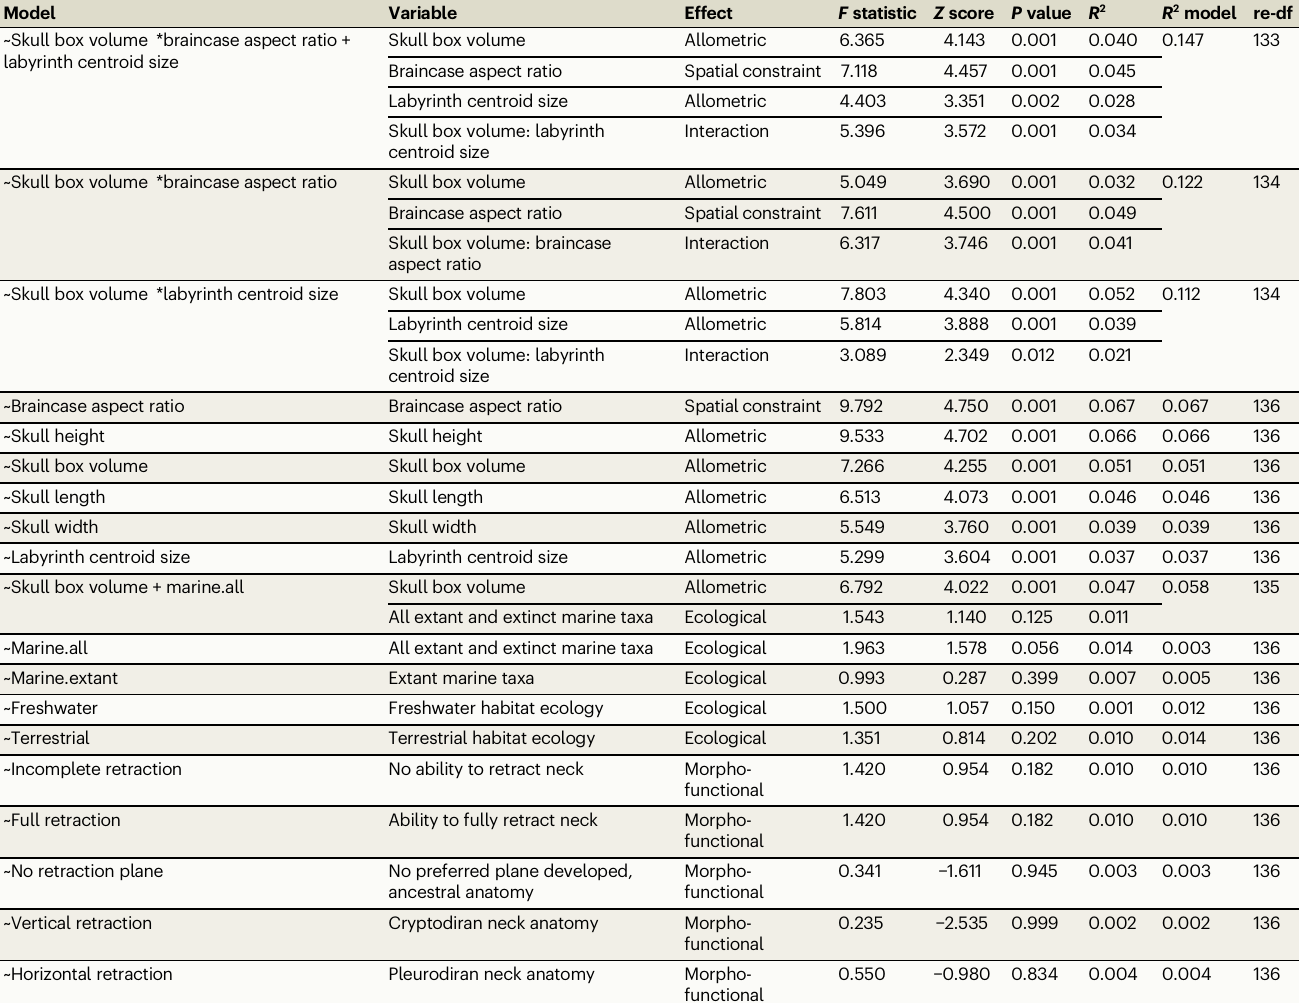
Table 1 | Results of selected phylogenetic Procrustes distance regressions of labyrinth shape ~ independent variables including fossils